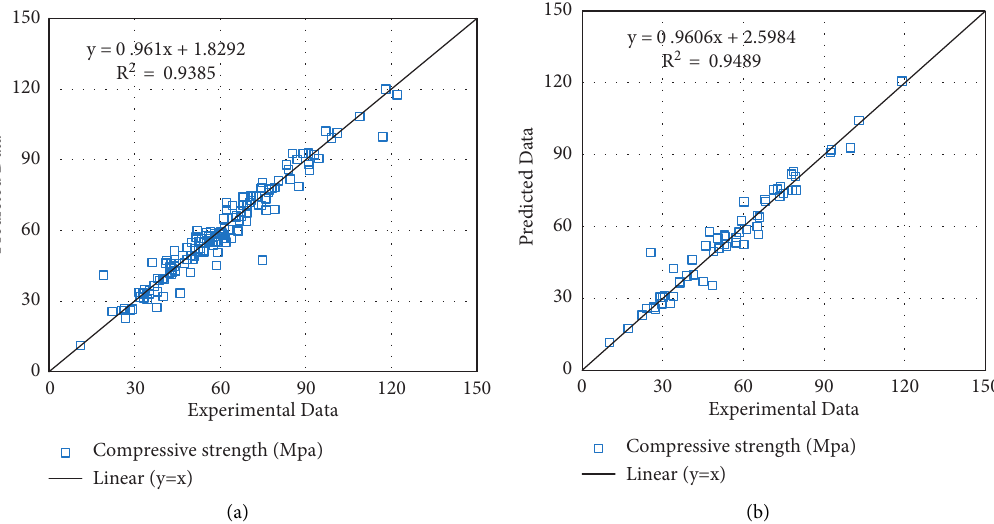
Figure 7: Experimental versus predicted values of SCC’s compressive strength for the ANN-GWO (7-13) model using training and testing data. (a) Training and (b)